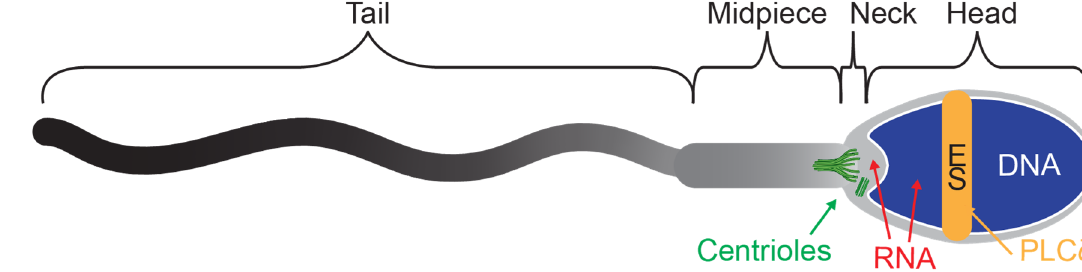
Figure 2. Various components of the sperm that may affect fertility. A mature sperm with DNA in the nucleus (blue), Activation protein phospholipase C zeta (PLC ζ ) in the equatorial segment (orange, ES), RNA throughout the sperm (red), and centrioles in the sperm neck (green).